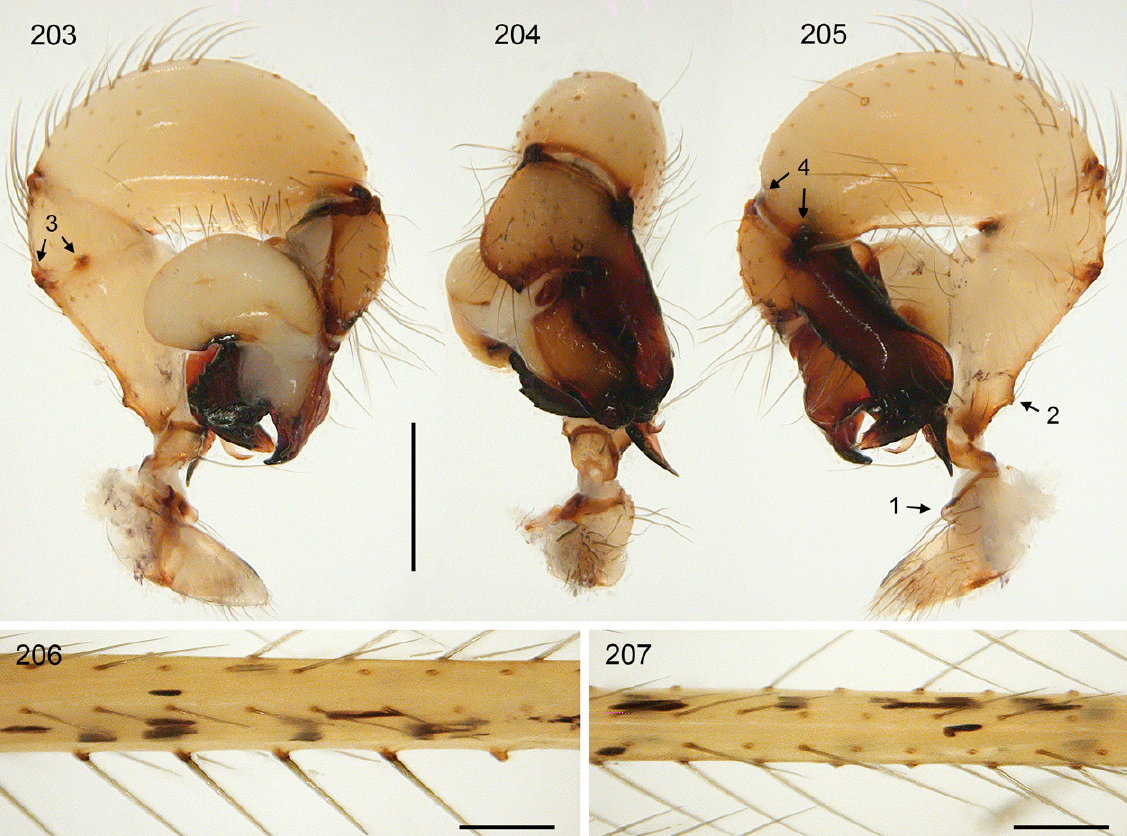
Figs 203–207. Maghreba saghro gen. et sp. nov.; male from Morocco, between Irherm and Tiferki (ZFMK Ar 22363). 203–205 . Left male palp, prolateral, dorsal, and retrolateral views; arrow 1: coxa apophysis; arrow 2: dorsal femur apophysis; arrows 3: femur-patella joints; arrows 4: tibia-tarsus joints. 206–207 . Male femora 1 and 2. Scale bars: 203–205 = 0.5 mm; 206–207 = 0.3